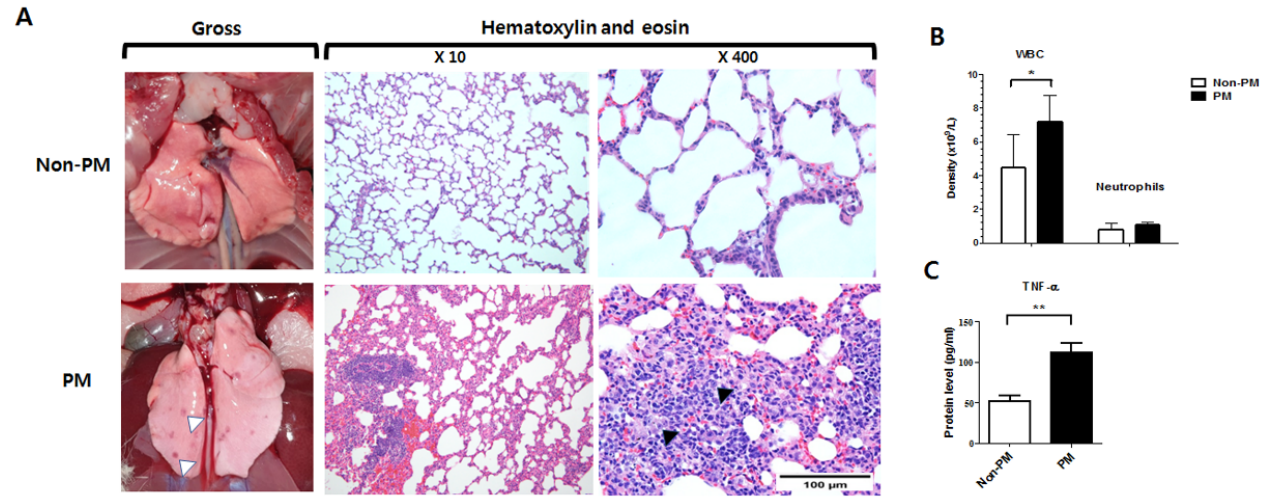
Figure 1. Evaluation of lung and systemic inflammation in particulate matter (PM)-exposed and control (non-PM) rats 6 weeks post-operation. ( A ) Gross and microscopic images of the lungs. Sections were stained with hematoxylin and eosin and observed under 10 × and 400 × magnification. The microscopic images revealed thickened interalveolar septa with increased numbers of lymphocytes and histiocytes. White arrow heads indicate the darkly spotted lesions in lungs of the PM group. Black arrow heads indicate the histiocytes in alveolar walls of the PM group. ( B ) White blood cell (WBC) and neutrophil densities in whole blood. ( C ) Serum levels of tumor necrosis factor-alpha (TNF- α ). Data are presented as means ± SD. * p < 0.05, ** p < 0.005.